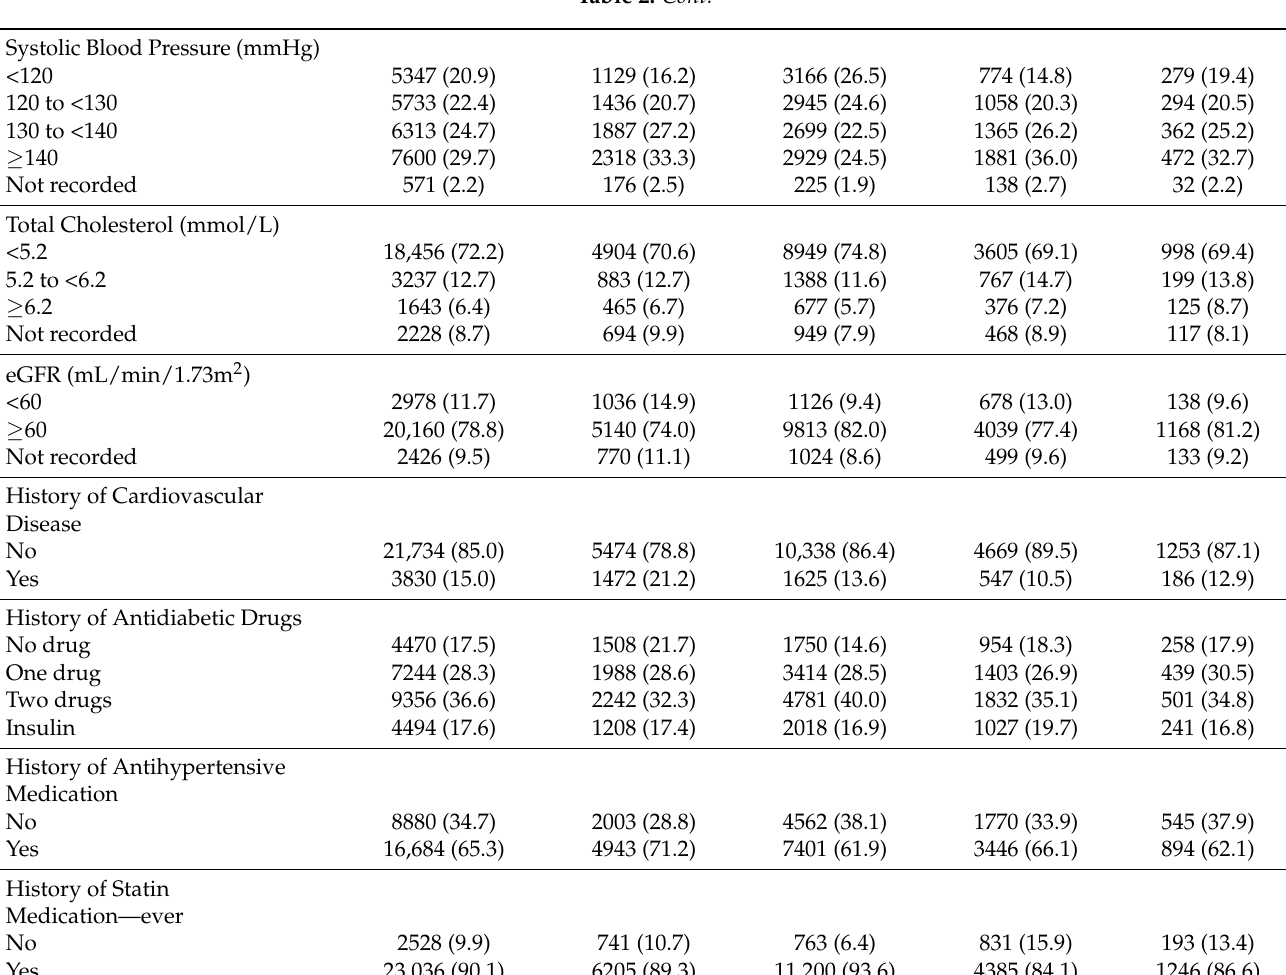
Table 1 shows the characteristics of 32,652 people with newly diagnosed diabetes at study baseline by different ethnic group. Townsend score was recorded in 99.7%, BMI was recorded in 91% and HbA1c level was available in 85.3%, SBP was recorded in 97%, total Cholesterol level was recorded in 94% and eGFR level was recorded in 93%. A greater proportion of South Asians 6536 (43%) were in the <45 years age group compared with White (16%), Black (25%) and other (25%) indicating early onset of diabetes among South Asians. Higher proportion of South Asians were in the most affluent group 4043 (26.4%) compared with other ethnic groups with 15–21% people in this group as shown in Table 1. Almost 70% of people in all ethnic groups had a BMI value that was greater than 25 kg/m 2 . Almost 50% of South Asians had lower blood pressure <130 mmHg compared with other ethnic groups with a proportion of people from 34–43% in the same blood pressure group. White ethnic groups had more than twice as high prevalence of CVD 1388 (16%) compared to other ethnic groups with prevalence of CVD ranging from